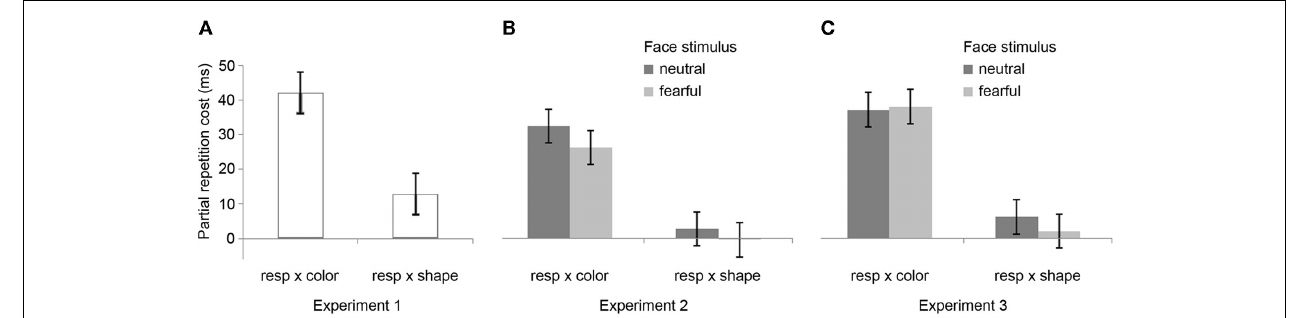
and stimulus features as a single value that captures the degree of binding between response and stimulus features by indicating the RT cost of partial repetitions [(feature repetition, response change + feature change, response repetition)/2 − (feature repetition, response repetition + feature change, response change)/2]. In other words, positive RT values reflect the relative slow-down in responses when the response repeats but a given